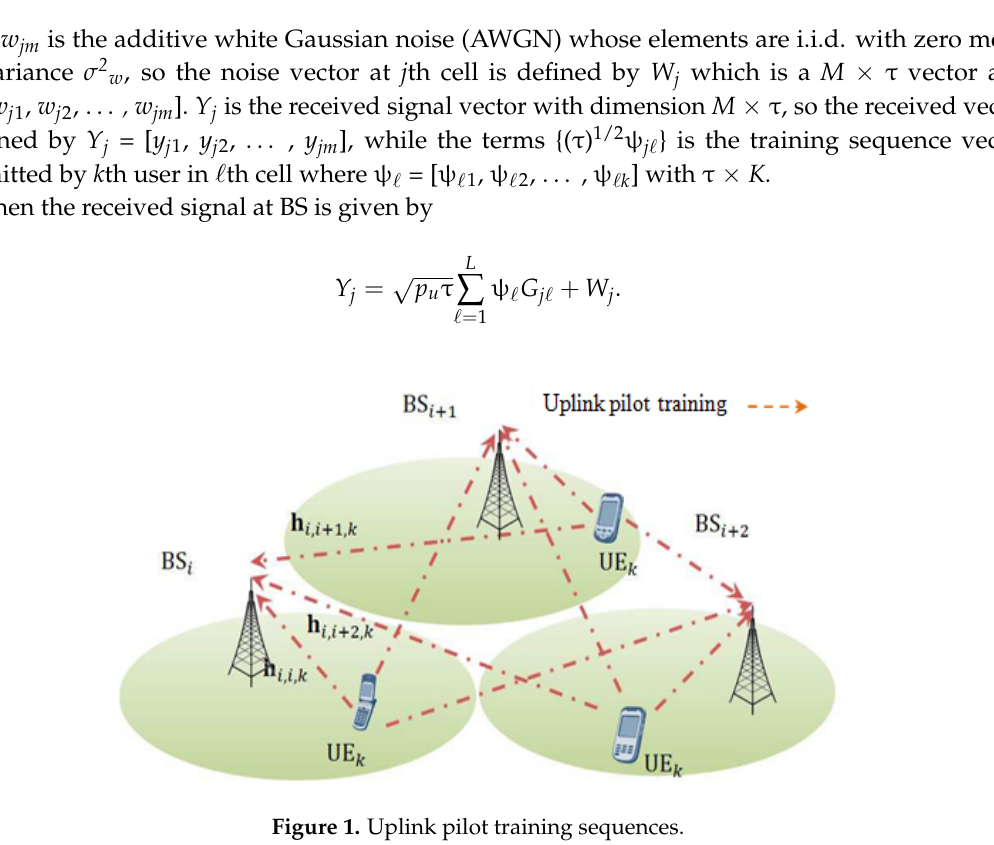
Figure 1. Uplink pilot training sequences.